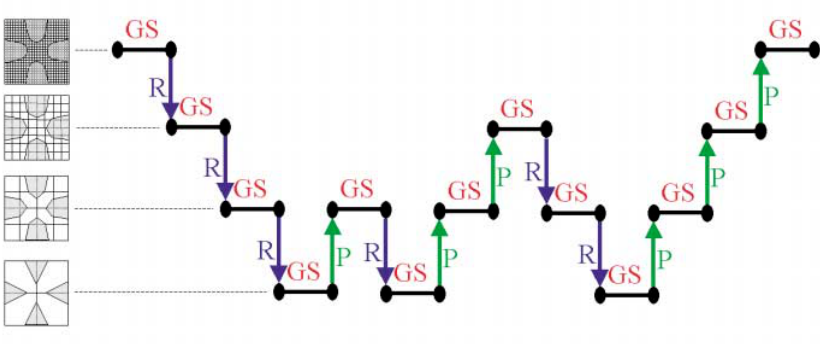
FIG. 2. (Color) Representation of the TOUTATIS cycle (GS: 3 Gauss-Seidel; R: restriction; P: prolongation).